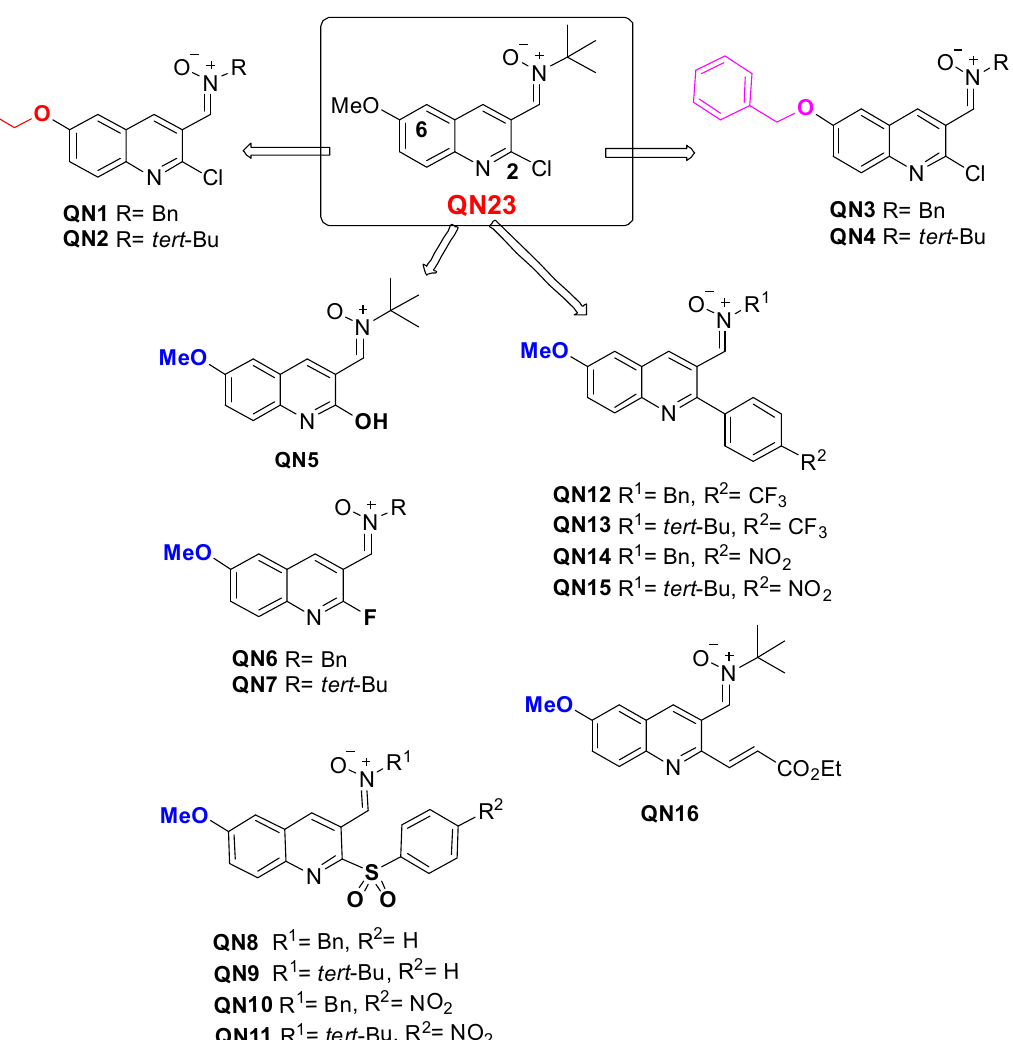
Figure 1. Structure of QN23 and the quinolylnitrones QNs 1–16 investigated in this work.